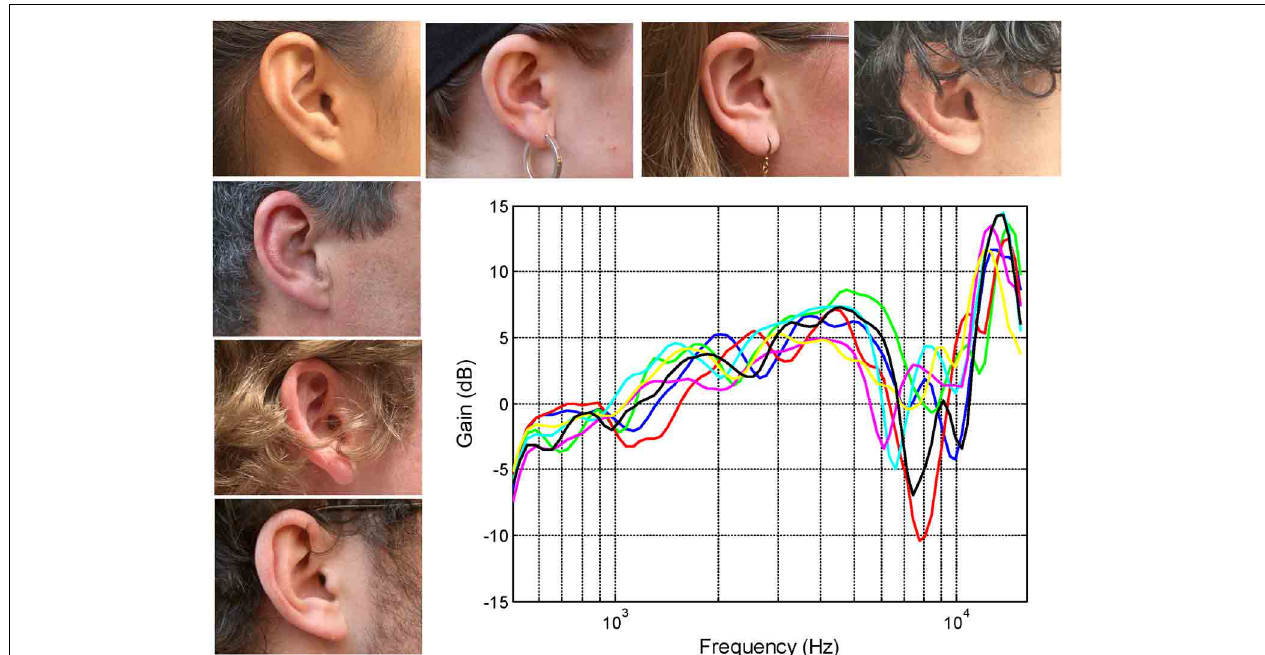
FIGURE 1 | The right ears of seven subjects together with their associated head-related transfer functions (HRTFs) recorded using a small microphone placed at the opening of the auditory canal (see Pralong and Carlile, 1994; Hammershoi and Moller, 2002). Note that